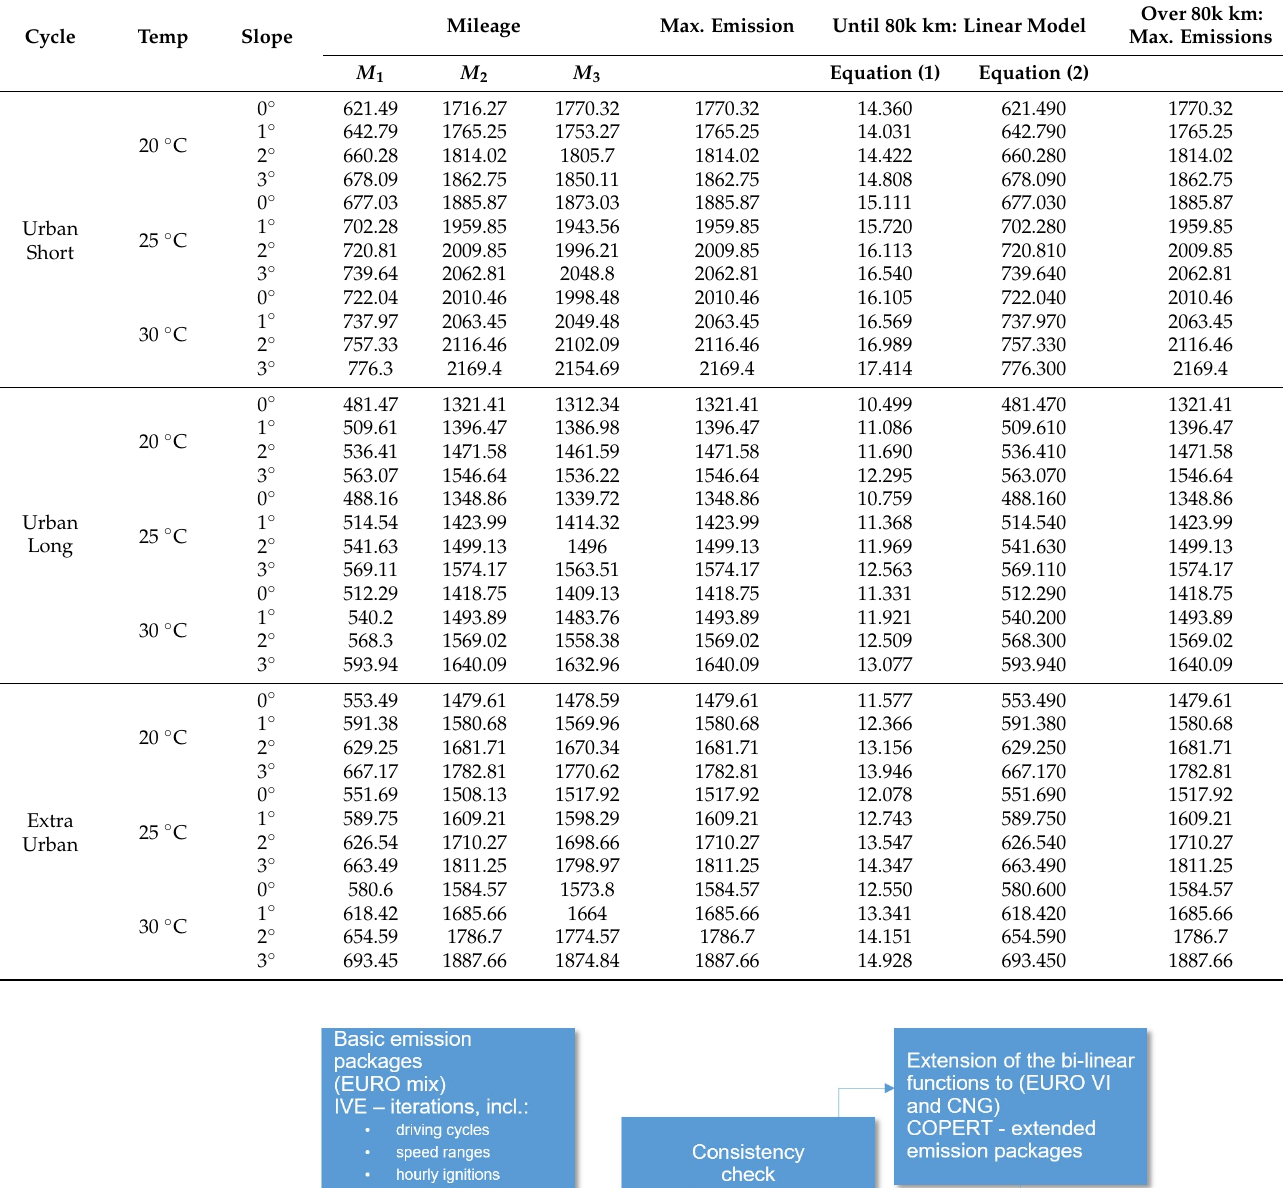
Table 3. Data process including variables driving cycles, temperature, slope, mileage (example).